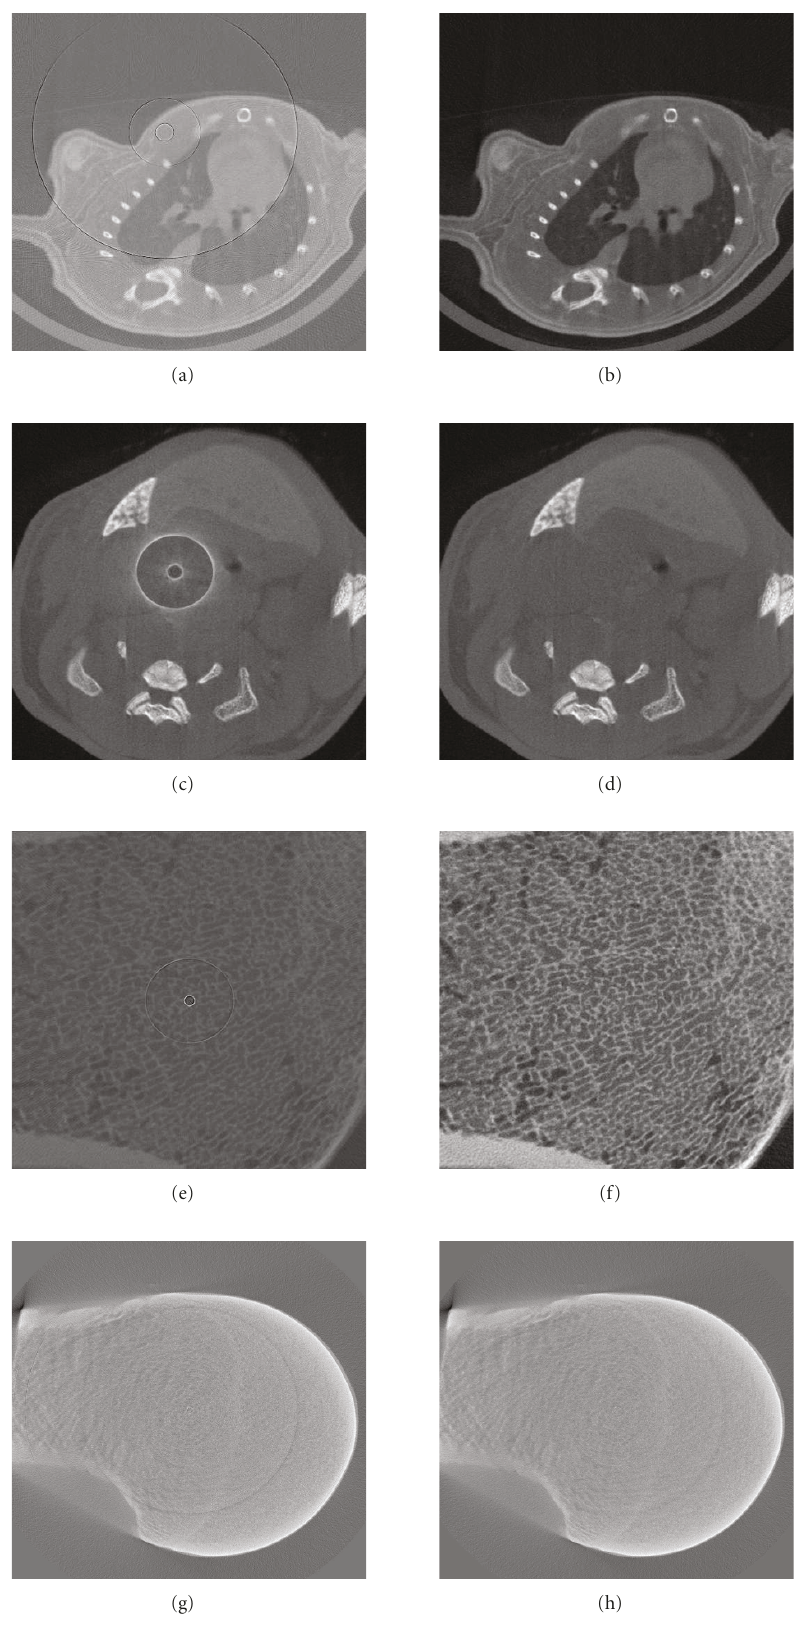
Figure 7: Reconstructed original images corrupted by ring artifact ((a): Rat chest, (c): Rat abdomen-2, (e): Trabecular bone, (g): Cow bone) and the corresponding ring corrected images using the proposed method ((b), (d), (f), (h),